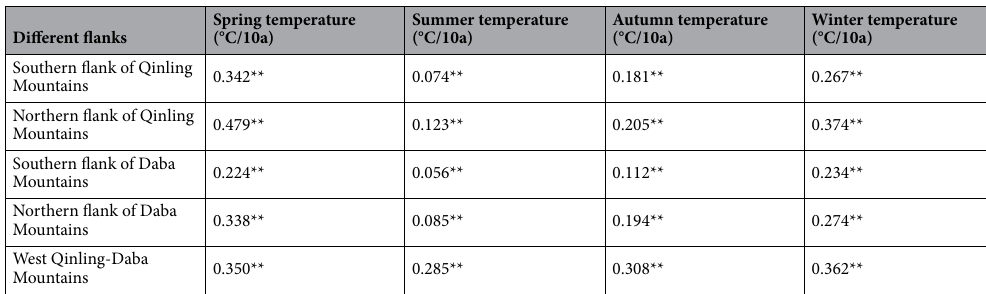
Table 1. Seasonal air temperature trends (°C/10a) on different flanks in the Qinling–Daba mountains during 1969–2018. **Indicates that the climate trends are significant at the 0.01 levels.